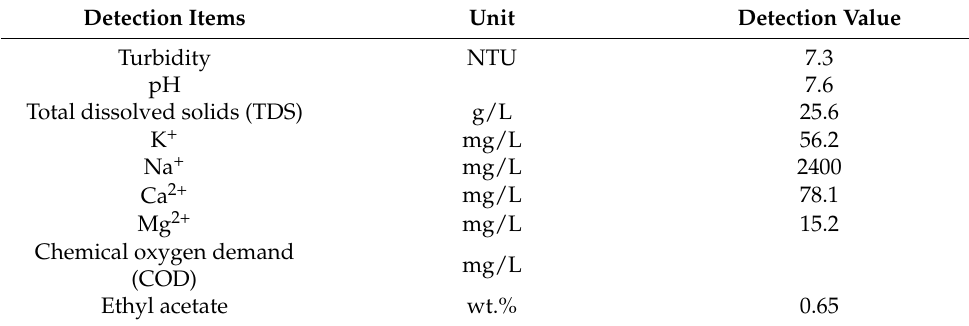
Table 6. Variation in the main components during the pervaporation process.